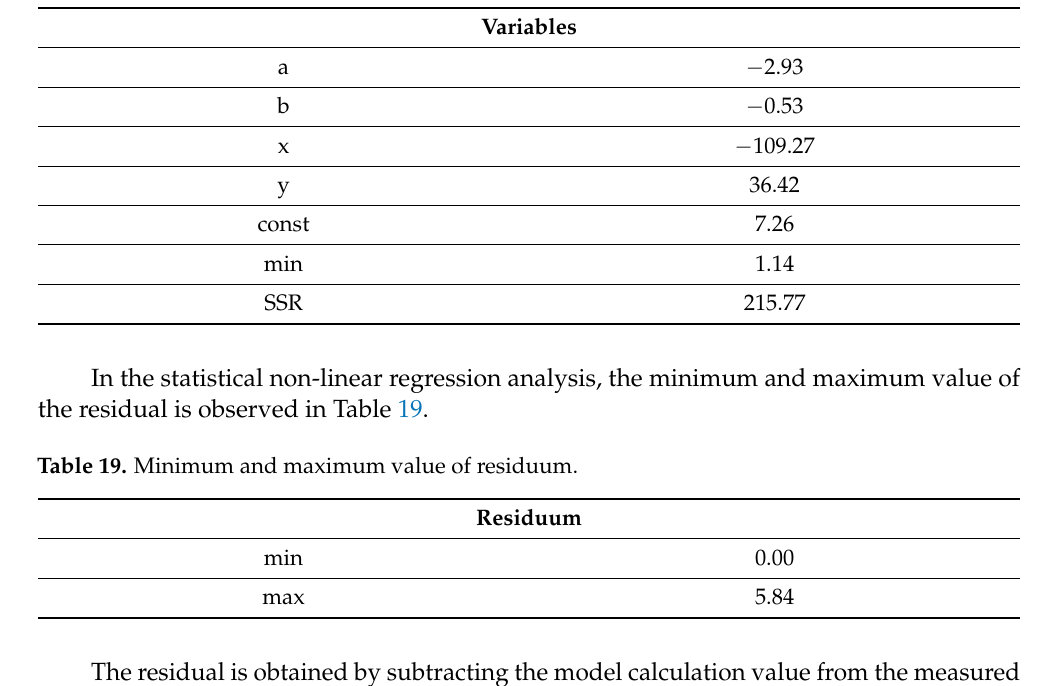
Table 18. Variables for non-linear regression equation.